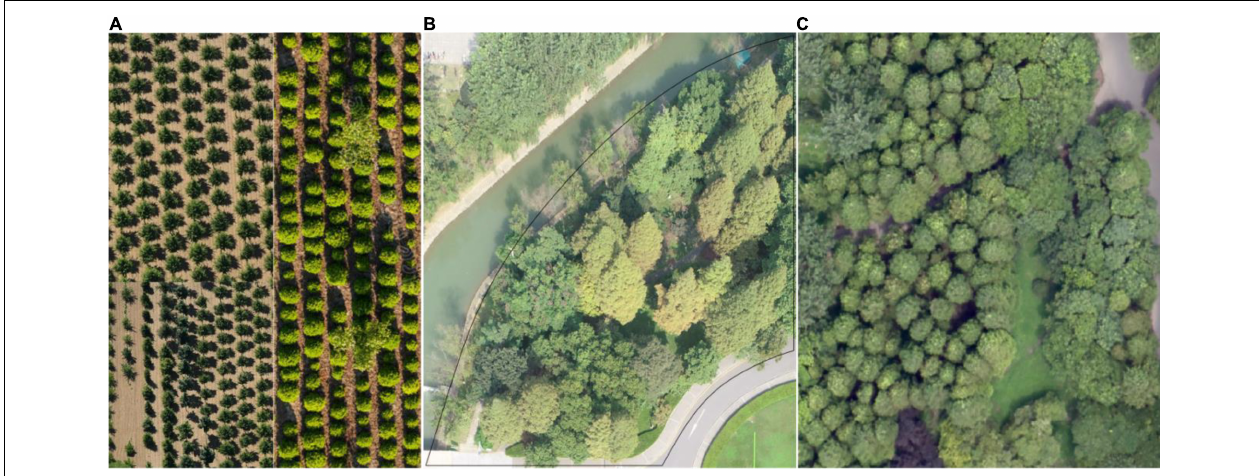
FIGURE 1 | Partial aerial photographs of the studied forest plots. (A) The tree nursery at the foot of Nanjing’s Purple Mountain and the (B) forest landscape and (C) mixed forest habitat on the campus of Nanjing Forestry University.